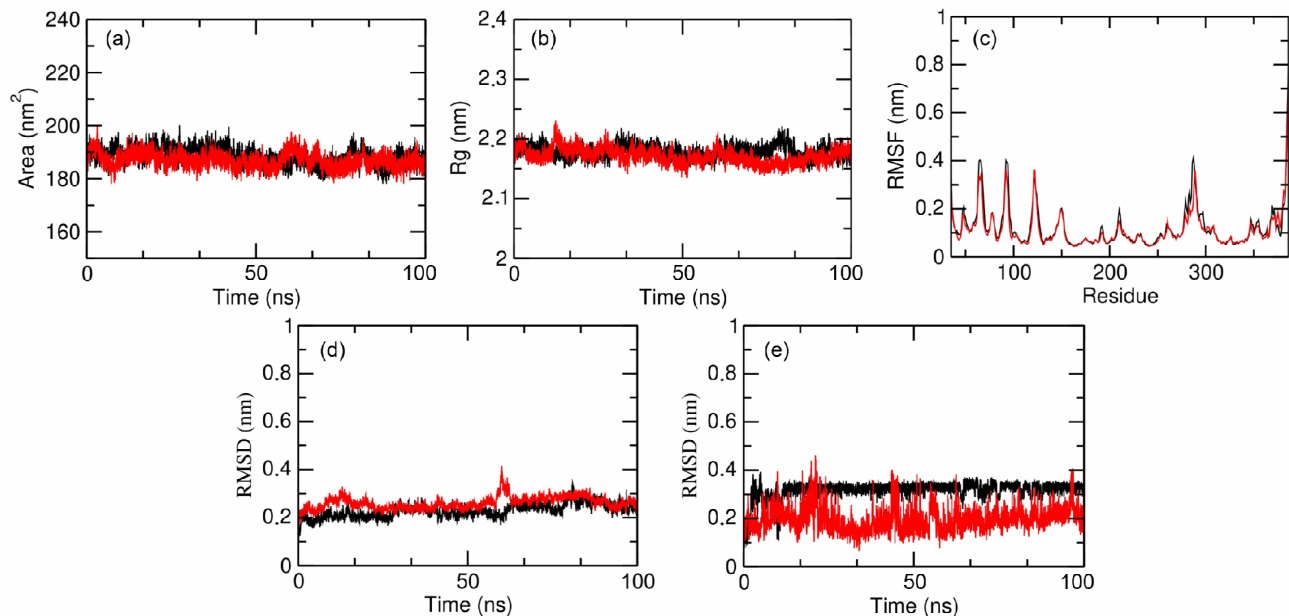
Figure 8. Results obtained by MD simulations carried out for the two poses of compound 1, previously obtained with Glide (black) and GOLD (red), and the respective protein–ligand complex structures within allosteric Pocket 7 of GSK-3 β . Resulting graphs showing ( a ) SASA, ( b ) Rg, ( c ) RMSF for the complexes, ( d ) RMSD for the complexes, and ( e ) RMSD only for ligands